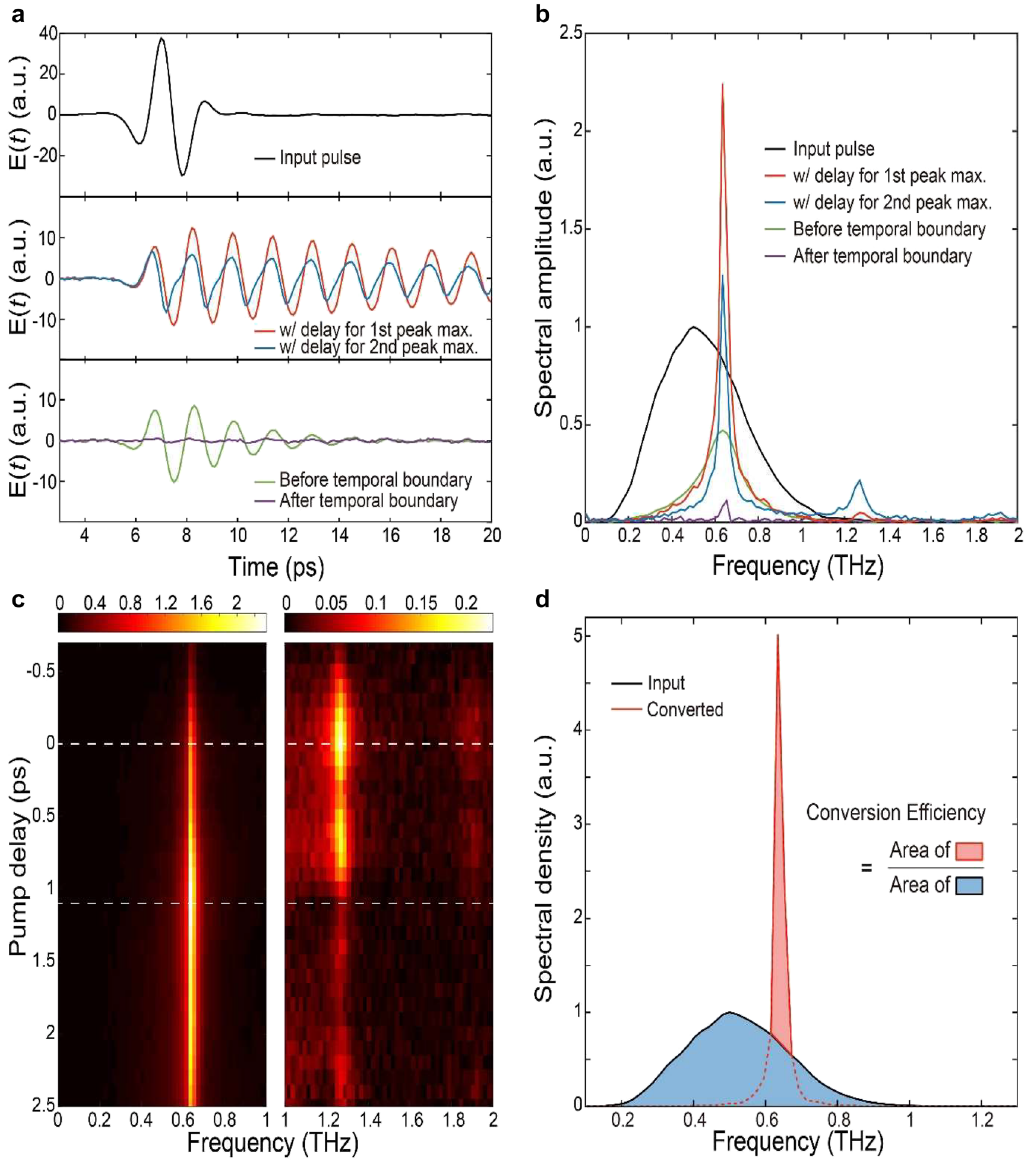
Figure 2: Transmitted THz waveforms and corresponding spectral amplitudes and intensities through the FP resonator with a cavity length of approximately 250 μ m. (a) Time traces of the input THz pulse (top panel), transmitted THz pulses with optimized time delays for fundamental (middle panel, red line) and second-order (middle panel, blue line) modal frequencies, and reference pulses (bottom panel, green and purple lines). The green line corresponds to the transmitted THz waveform measured without pulsed excitation, while the purple line corresponds to the transmitted THz waveform measured with pulsed excitation approximately 10 ps prior to the arrival of an input THz pulse on the GaAs substrate. (b) Spectral amplitudes of the corresponding transmitted THz pulses shown in (a). (c) Spectral amplitudes plotted as a function of the time delay. Optimized time delays for fundamental and second-order modal frequencies are denoted by white dashed lines. (d) Graphical representation of the energy conversion ef fi ciency estimation. The reference input THz pulse is taken as that directly transmitted through the semi-insulating GaAs substrate without pulsed